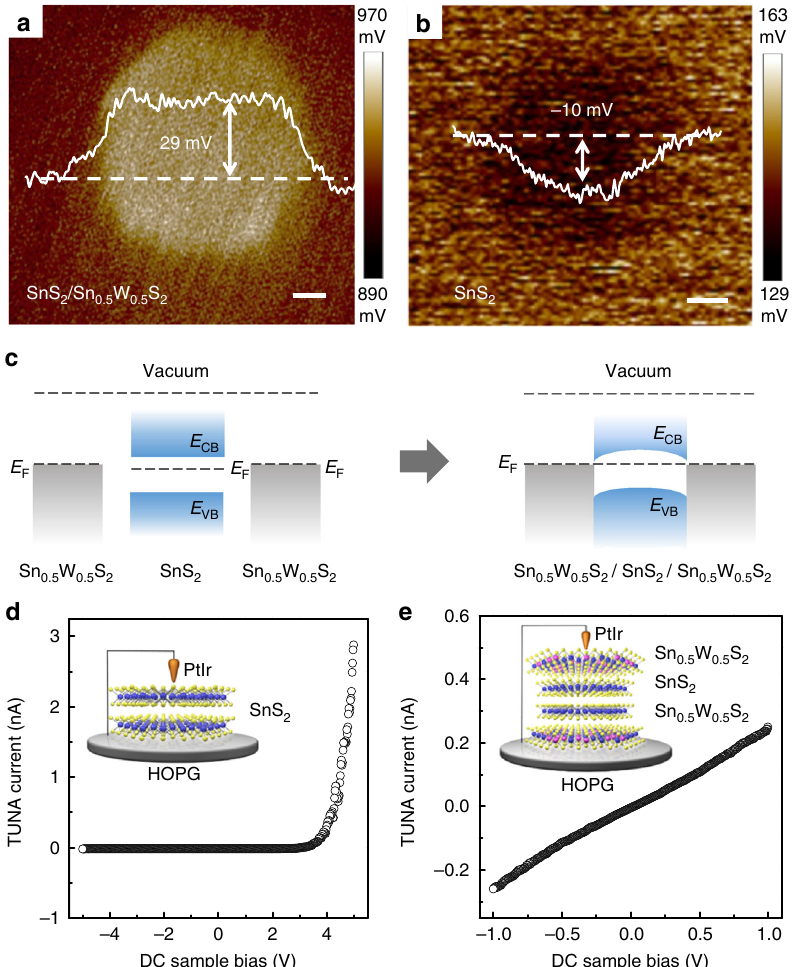
Fig. 5 KPFM and TUNA analyses of SnS 2 and Sn 0.5 W 0.5 S 2 /SnS 2 heterostructures. 2D potential images of a a typical Sn 0.5 W 0.5 S 2 /SnS 2 heterostructure (scale bar, 200 nm) and b a typical SnS 2 nanoplate deposited on a SiO 2 /Si substrate coated with a thin fi lm of Au/Cr (i.e., Au/Cr/SiO 2 /Si) (scale bar, 100 nm). c Schematic band alignment diagram for Sn 0.5 W 0.5 S 2 and SnS 2 before and after contact. E F , E CB , and E VB denote Fermi level, conduction